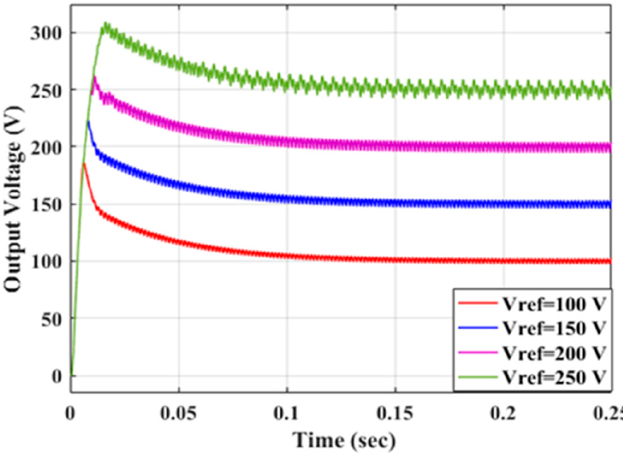
Figure 10. Output voltage response at turn-on angle control (at turn-off = 0.0).